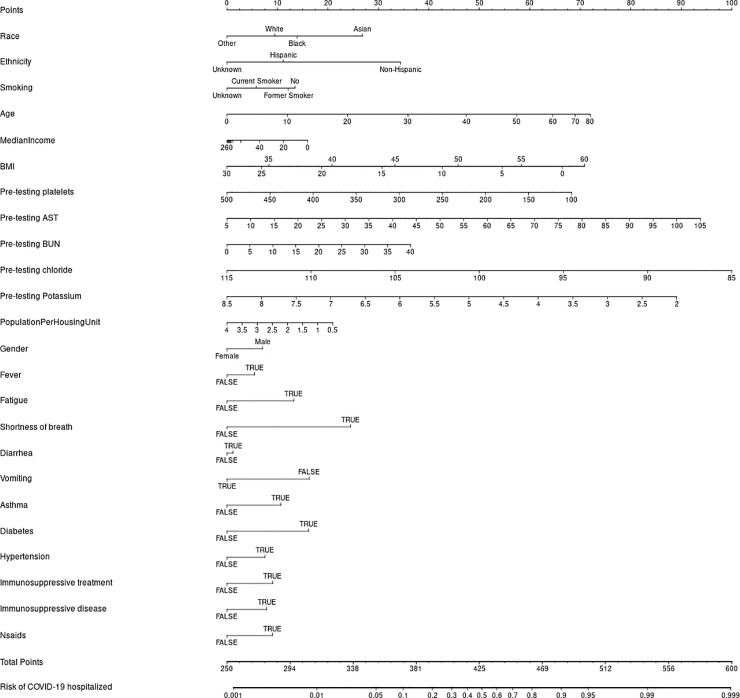
A nomogram (graphical version of the model) is shown.Line 1 is used to calculate the points that are associated with each of the predictor variables. Each subsequent line represents a predictor in the final model. The patient’s characteristic is found on each line, and from it, a vertical line is drawn to find the points that are associated with each value. All the points are then totaled and located on second to last line. A vertical line is drawn down to the bottom line to locate the predicted risk of hospitalization produced by the model.